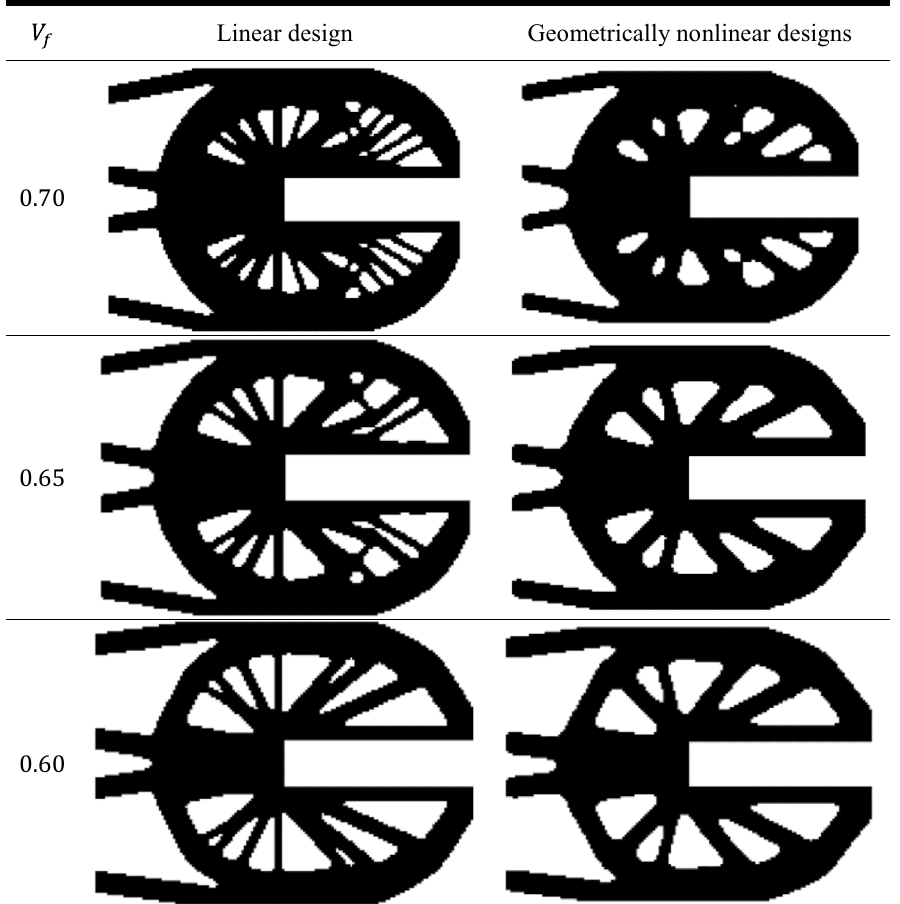
Table 5. Topological resulted shapes of the U-shaped plate in case of deterministic